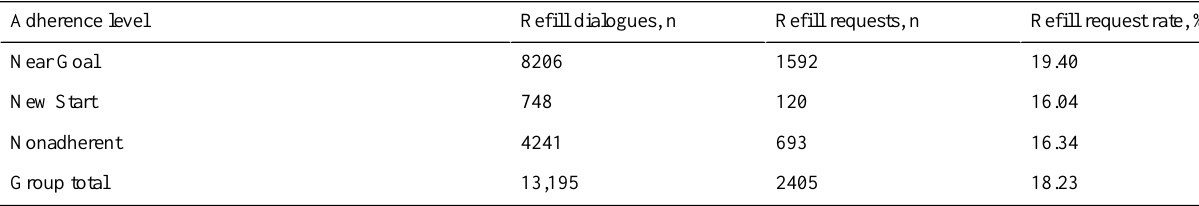
Figure 3. Refills requests by hour from initial